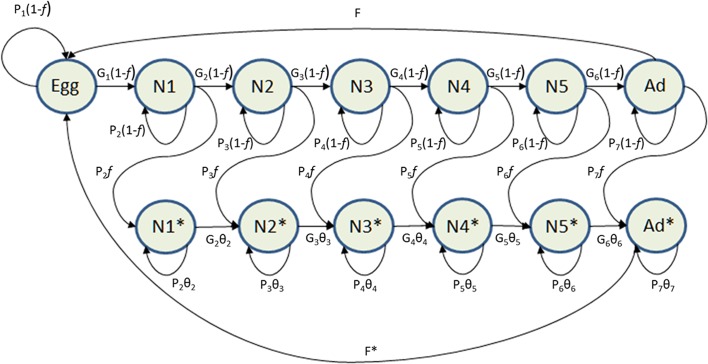
Life cycle diagram of the T. infestans matrix population model.Asterisks identify infected individuals. N1—N5 refers to nymph stage 1 through stage 5 of T. infestans. Parameters and symbols are defined in the text.